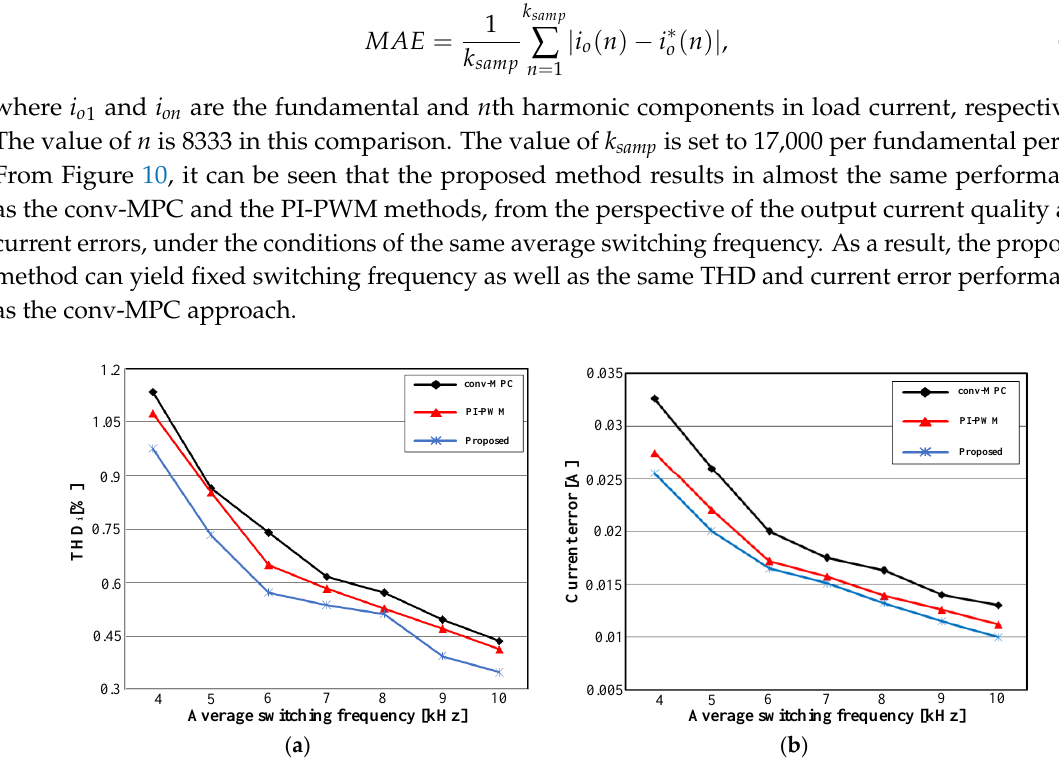
Figure 10. Comparative results of the output current and reference current used by the conv-MPC, the PI-PWM, proposed method methods as a function of the average switching frequency ( f avg = 5 kHz): ( a ) THD values; ( b ) current errors ( V dc = 100 V, i o* = 5 A).